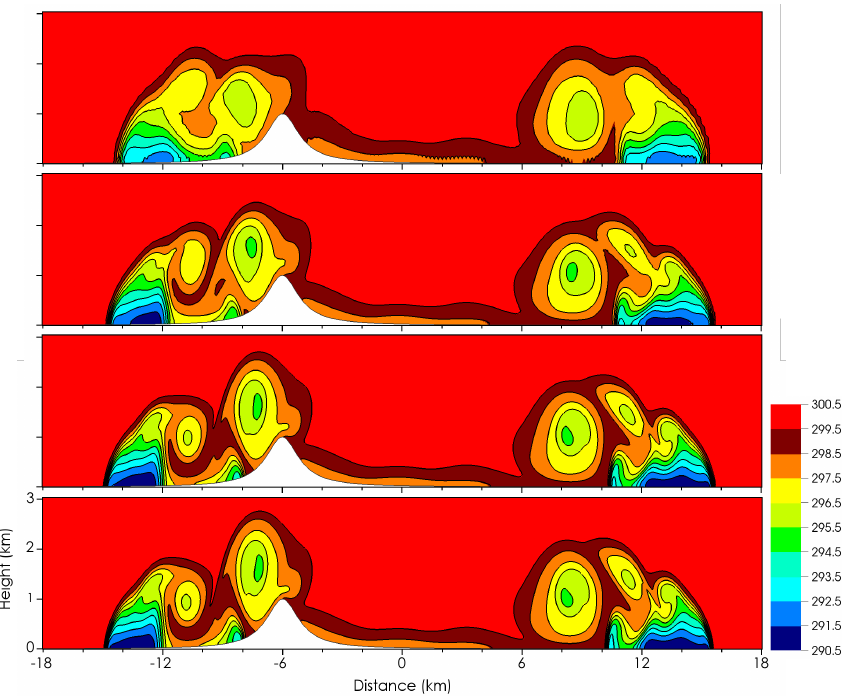
Figure 10. Potential temperature field at t = 900 s for the density current test case with an ’Agnesi’ hill on the left side of the domain and for different grid spacings ∆ x = ∆ z = 200 , 100 , 50 , 25 m (top to bottom).